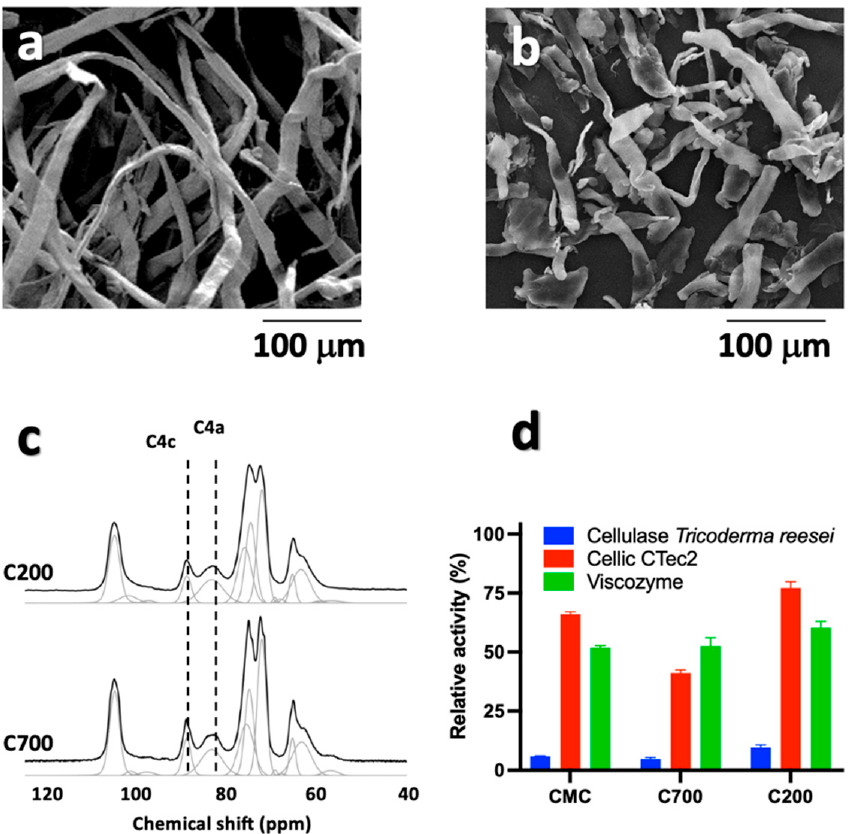
Figure 1. SEM images of ( a ) C700 and ( b ) C200. In panel ( c ), 13 C CP-MAS NMR spectra of C200 and C700 samples are shown. The resonances used for quantitative evaluation of the crystallinity index (C4c and C4a) are highlighted. ( d ) Relative activity of treatment of cellulase from T. reesei , Viscozyme ® L, and Cellic Ctec2 on CMC, C200, and C700.